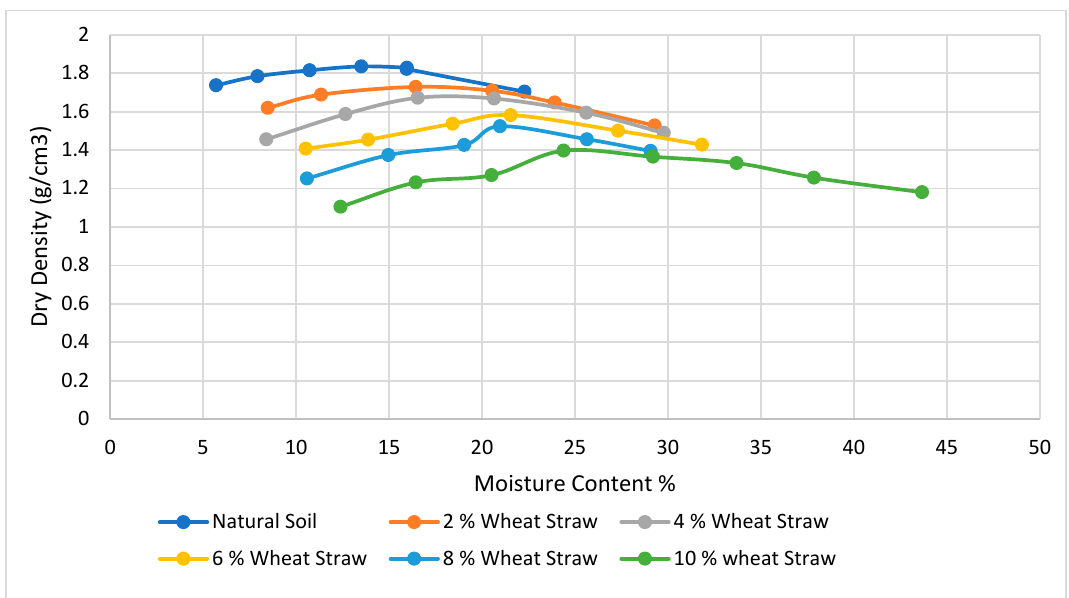
Figure 10. Marble dust Proctor results.